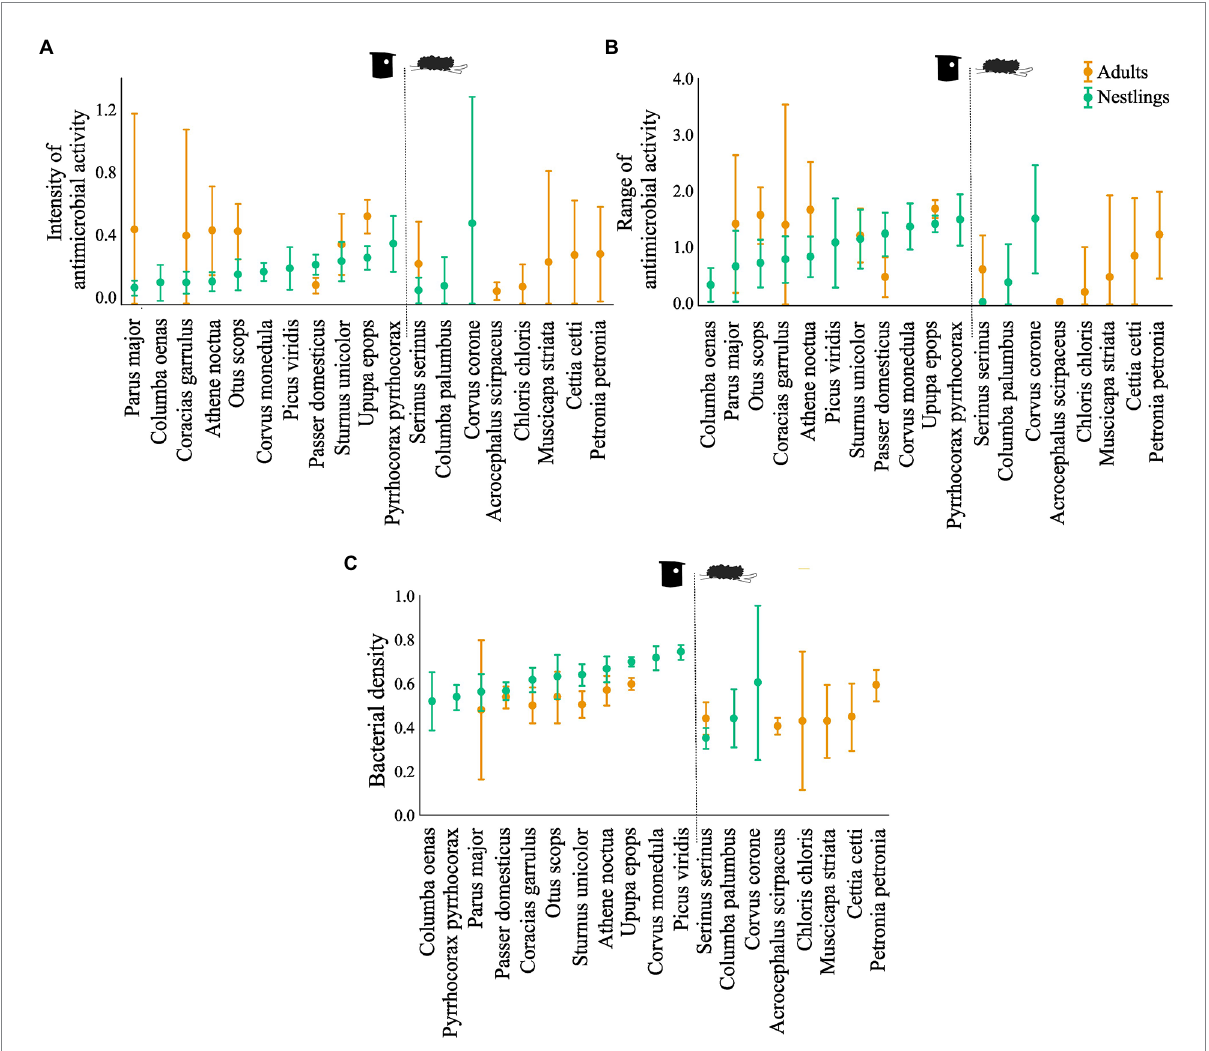
FIGURE 1 Antimicrobial capacity: (A) antimicrobial activity (average values of the width of antagonistic halos (mm) when tested against each of the nine indicator bacteria) and (B) antimicrobial range (Shannon index of the antimicrobial activity), of the bacterial communities associated to the uropygial gland skin of different bird species. (C) Bacterial density on the gland surface of the same species. Results for adults and nestlings are shown in different colours. Values are means ±95% CI. CI are not symmetric because negative values are not